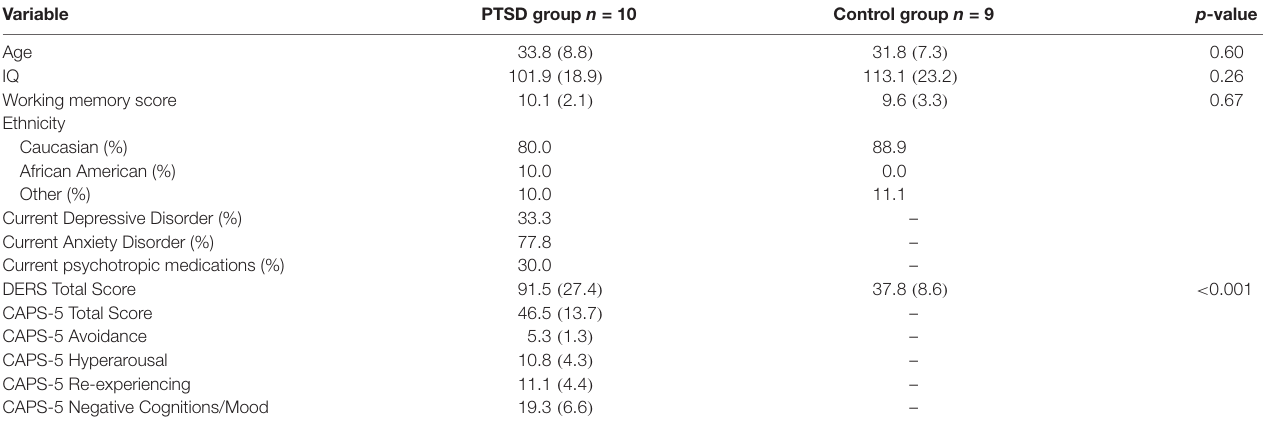
Frontiers in Systems Neuroscience |